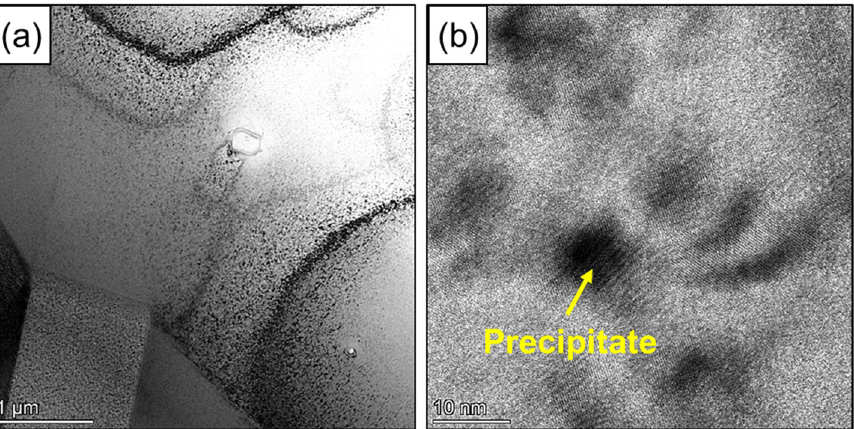
Figure 7. Bright-field TEM and the HRTEM image of the sample after the 725 °C aging treatment: ( a ) bright-field TEM image, ( b ) HRTEM image.